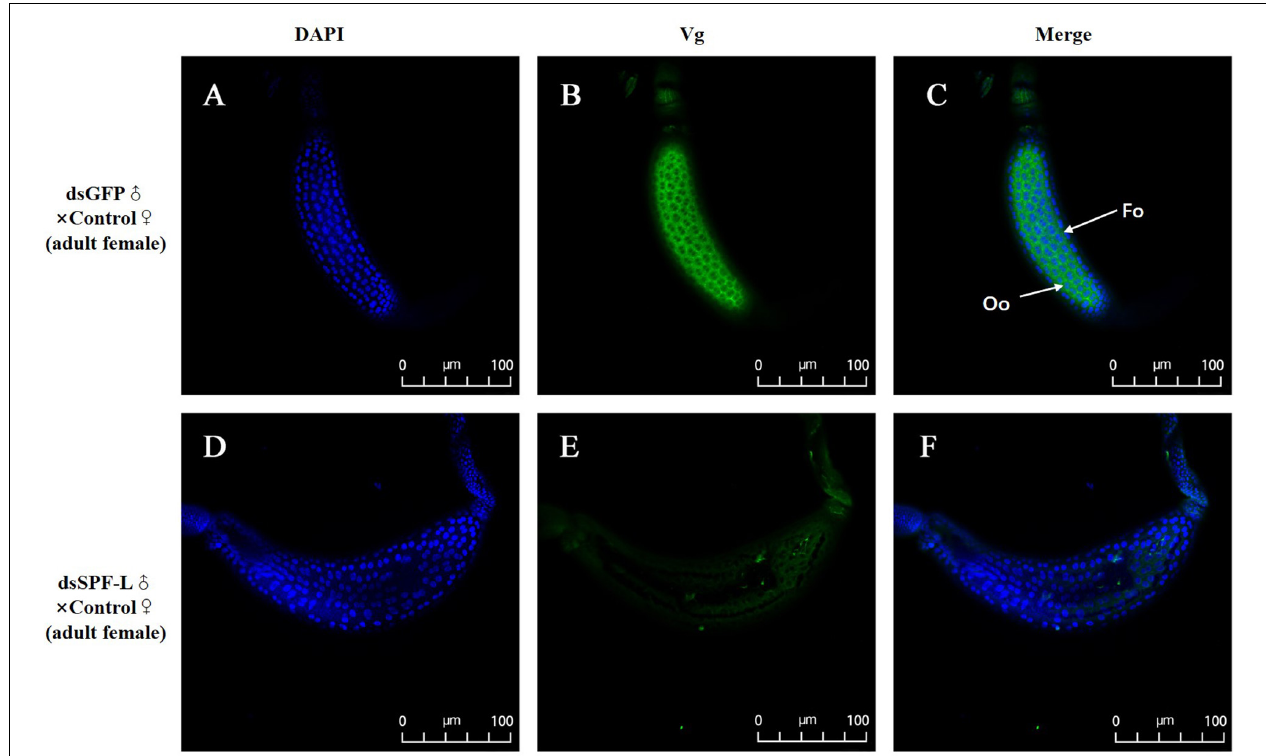
FIGURE 8 | Influence of mating with dsSPF-L-treated males on BPH ovarian Vg synthesis at 2 DAE. (A,D) DAPI stained nuclei (blue). (B,E) Vg protein detected with a goat anti-rabbit IgG labeled with Dylight 488 (green). (C,F) Merged images. The fluorescence staining images were captured using a Zeiss LSM 780 confocal microscope. In panel (C) , Fc: follicle cells; Oo: